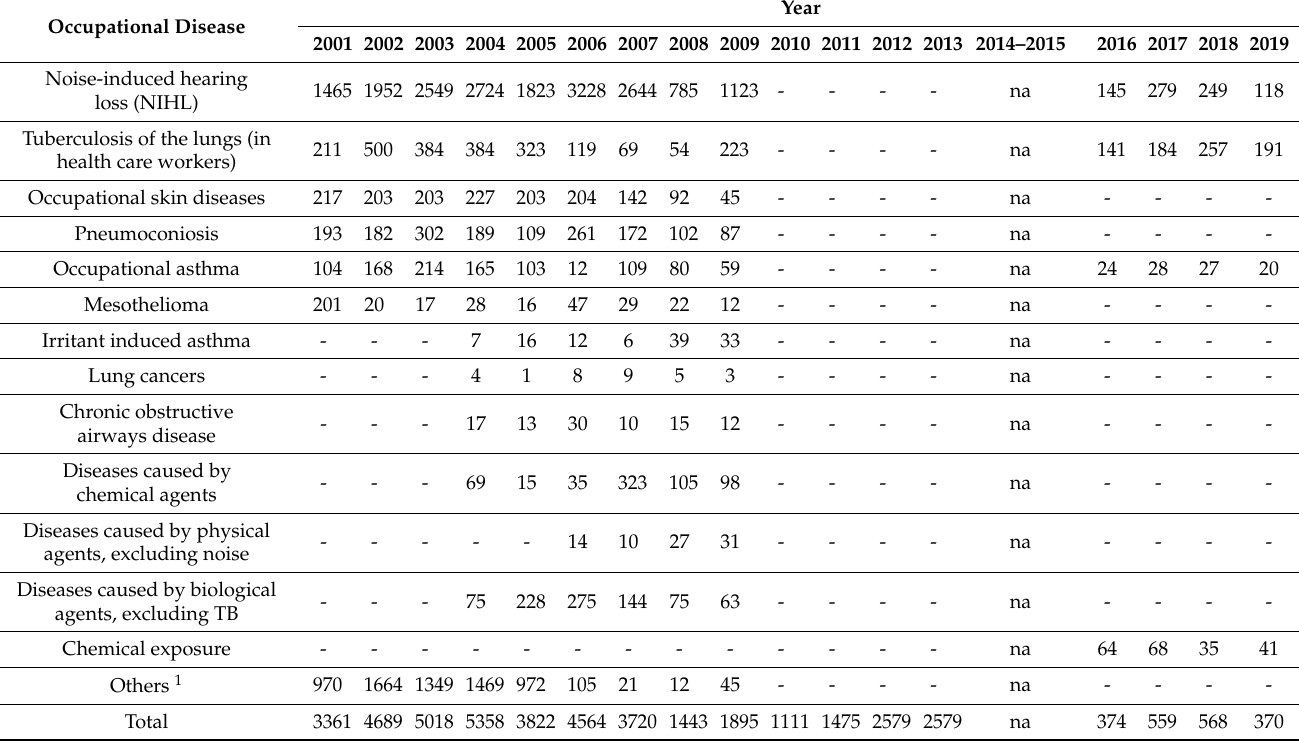
Table 1. Compensated ODs in South Africa